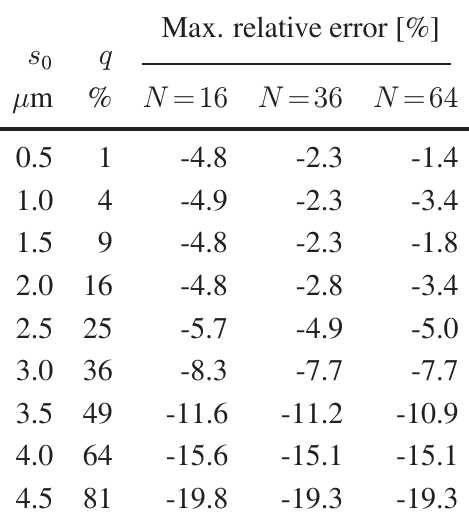
Table 2 . Maximum relative errors in the translational motion damping coef fi cient Z PPR method. Each row includes cases for d = 1 µ m or 2 µ m and h made against the 3D simulations with the N-S